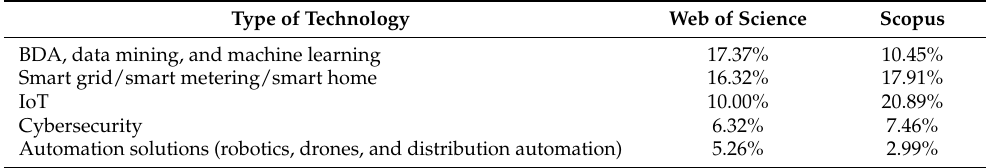
Table 14. The most important technologies used, from the perspective of publications indexed in Web of Science and Scopus 1 .